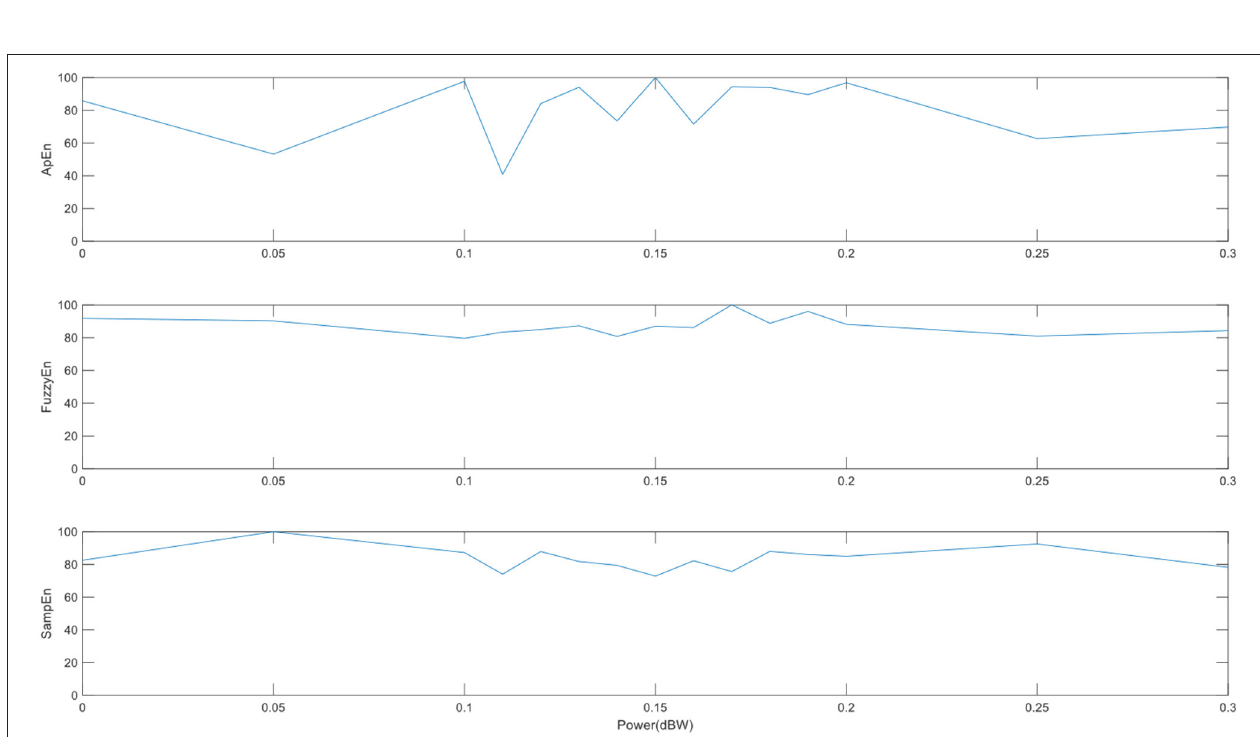
FIGURE 5 | The performances of the three entropies adding different noise level. (The abscissa is the intensity of the specified output noise in the unit).